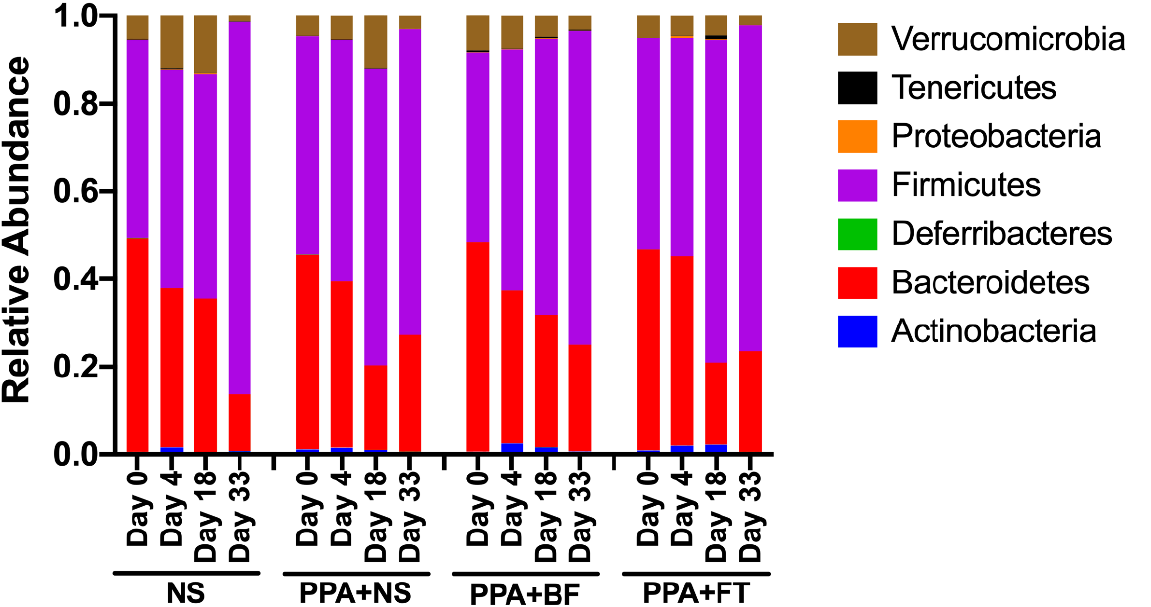
Figure 4. Identified bacterial taxa at the phylum level. Relative abundance of assigned bacterial phyla in all samples are clustered at each experimental group. Each column represents the mean relative abundance of the identified phyla at each timepoint per group.